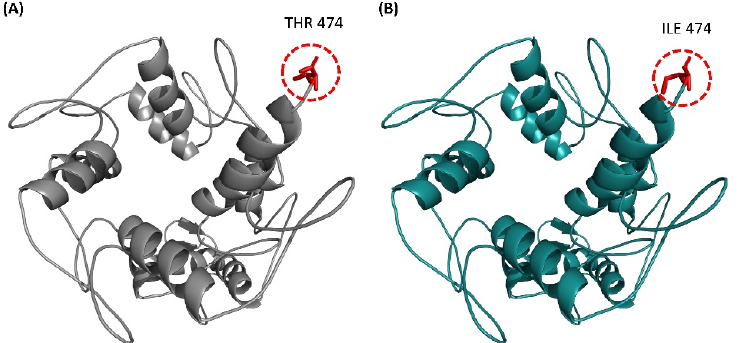
Figure 1. 3D structure of C2-H2 (Kruppel; res 171–474) domain of ZNF141 WT and ZNF141 T474I protein with the residual position of the SNP; T474I mapped on it. ( A ) 3D structure of C2-H2 domain with Thr474 encircled and colored in red. ( B ) 3D structure of mutant C2-H2 domain with Thr474 encircled and colored in red. All the loops are represented in yellow color and helices in